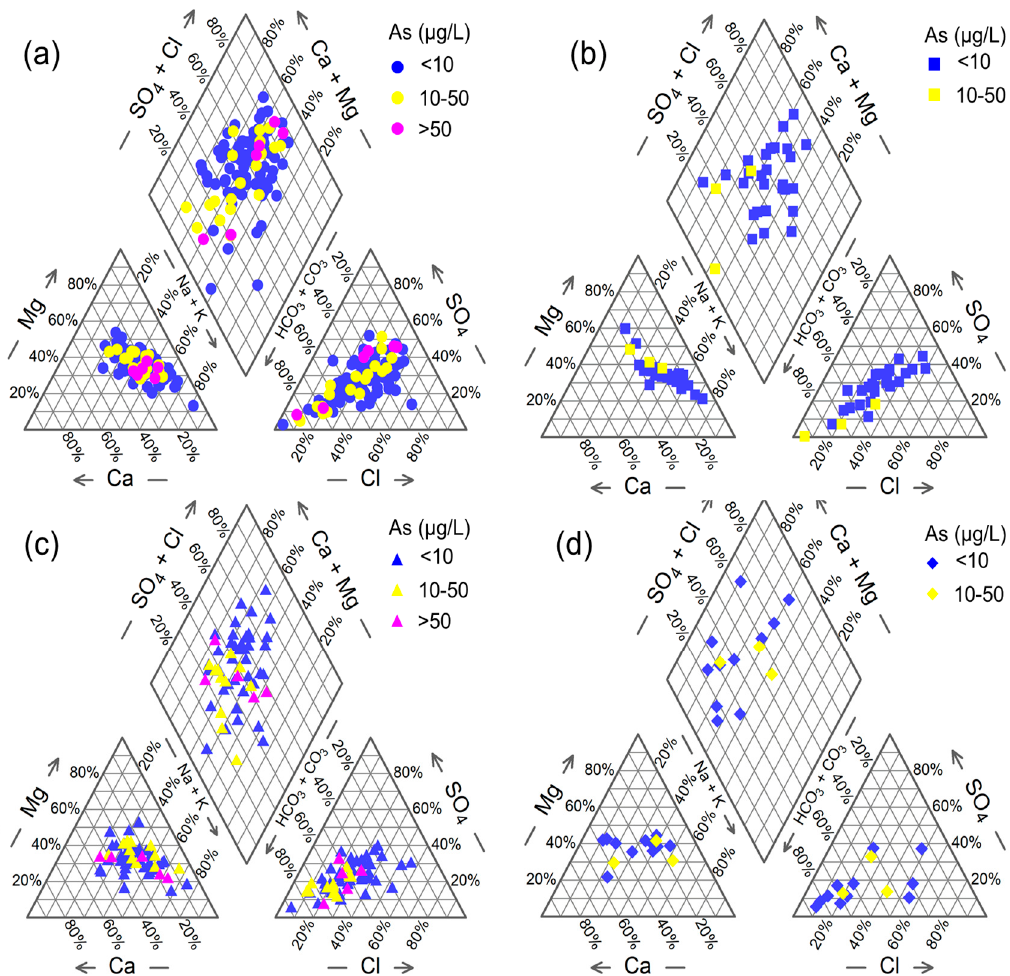
Figure 3. Piper plot of the C2 ( a ), C3 ( b ), C4 ( c ), and C5 ( d ) groundwater systems.